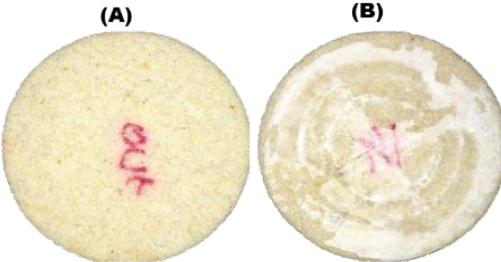
Figure 2. Pictures of Bentheimer sandstone core after CO 2 was injected at 1 mL/min into the core which was initially saturated with 120 g/L NaCl brine. ( a ) No salt cake observed at the core outlet. ( b ) Massive salt cake found at the injection inlet.